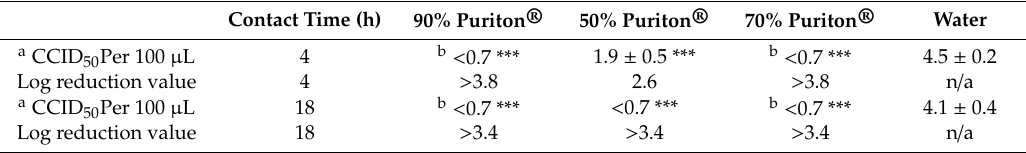
Table 3. Virucidal e ffi cacy of Puriton ® against Influenza A virus (H5N1) after 4 or 18 h of liquid–liquid contact at 22 ± 2 ◦